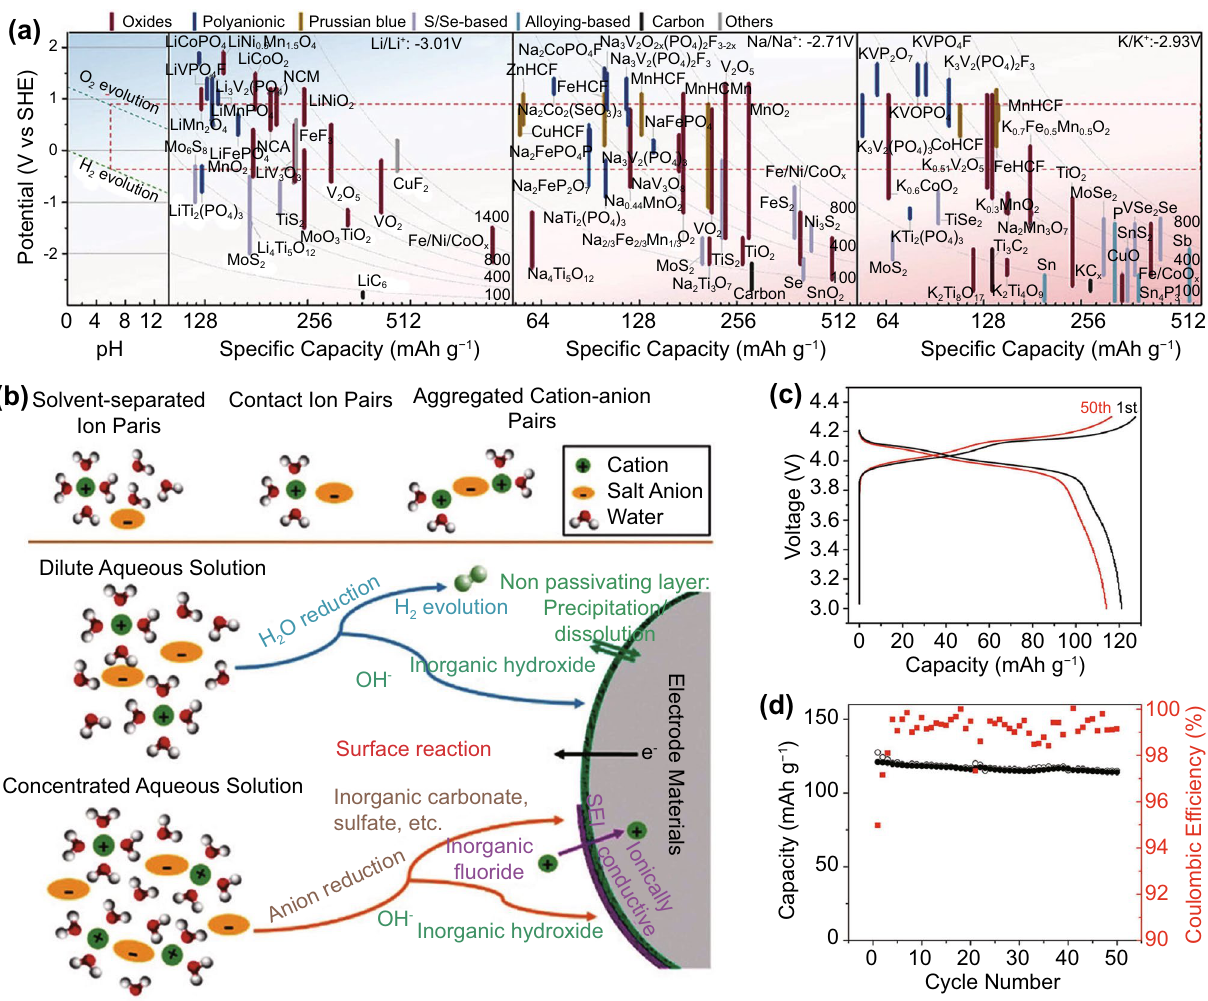
Fig. 15 a Illustration of the position of the ESW of water relative to common anodes and cathodes for lithium and sodium ions [222]. Crea- tive Commons License (CC BY-NC 4.0). b Illustration of some solvated ion-water interactions, and the shift from water to anion reduction in response to an increase in salt concentration [220] . Copyright 2020, John Wiley and Sons. c High voltage and d Coulombic efficiency achieved by a combined WiSE and artificial SEI approach, showing expansion of the ESW to above 4 V for LIBs [223] . Copyright 2017,